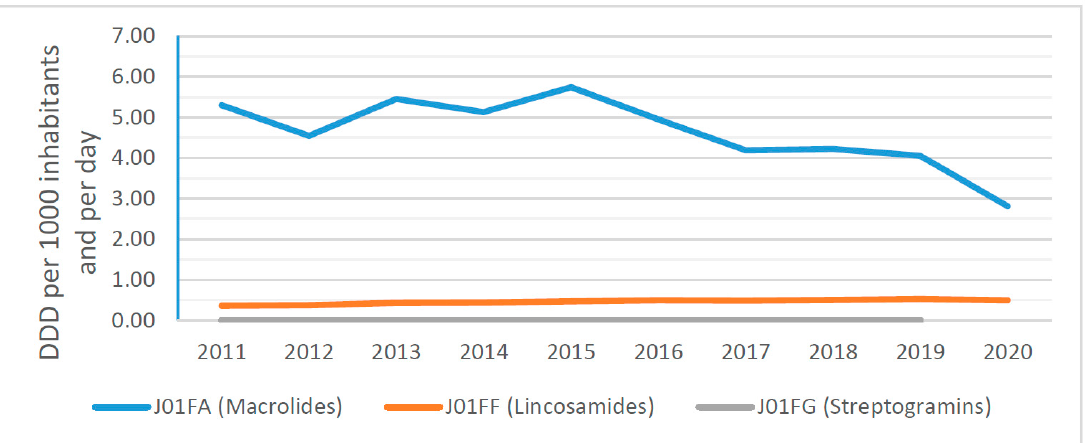
Figure 4. Macrolides, lincosamides and streptogramins (ATC group J01F) in the community.